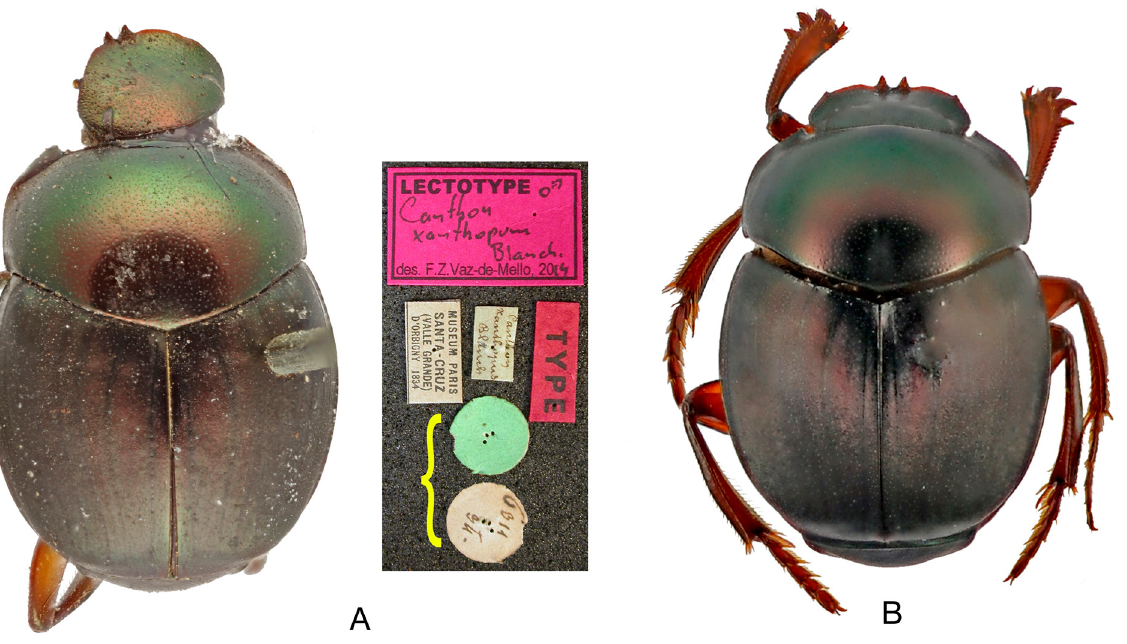
Fig. 45. Canthon xanthopus Blanchard, 1846. A . Lectotype and its labels. B . An